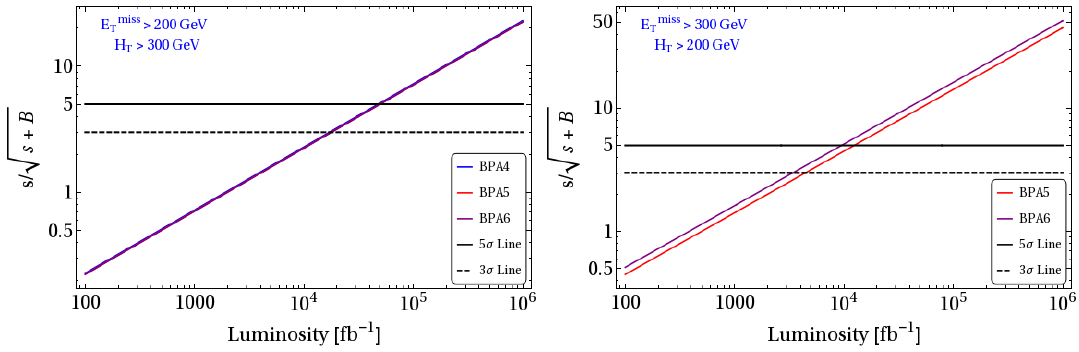
Figure 22 . Signal signi(cid:12)cance (cid:27) = S p of OSD events for select few benchmark points (see S + B table 2) at LHC with E CM = 14 TeV as a function of integrated luminosity. Di(cid:11)erent combinations of =E T ; H T cuts are chosen in left and right panel (mentioned in inset). 3 (cid:27) (black dashed) and 5 (cid:27) (black thick) lines are indicated as